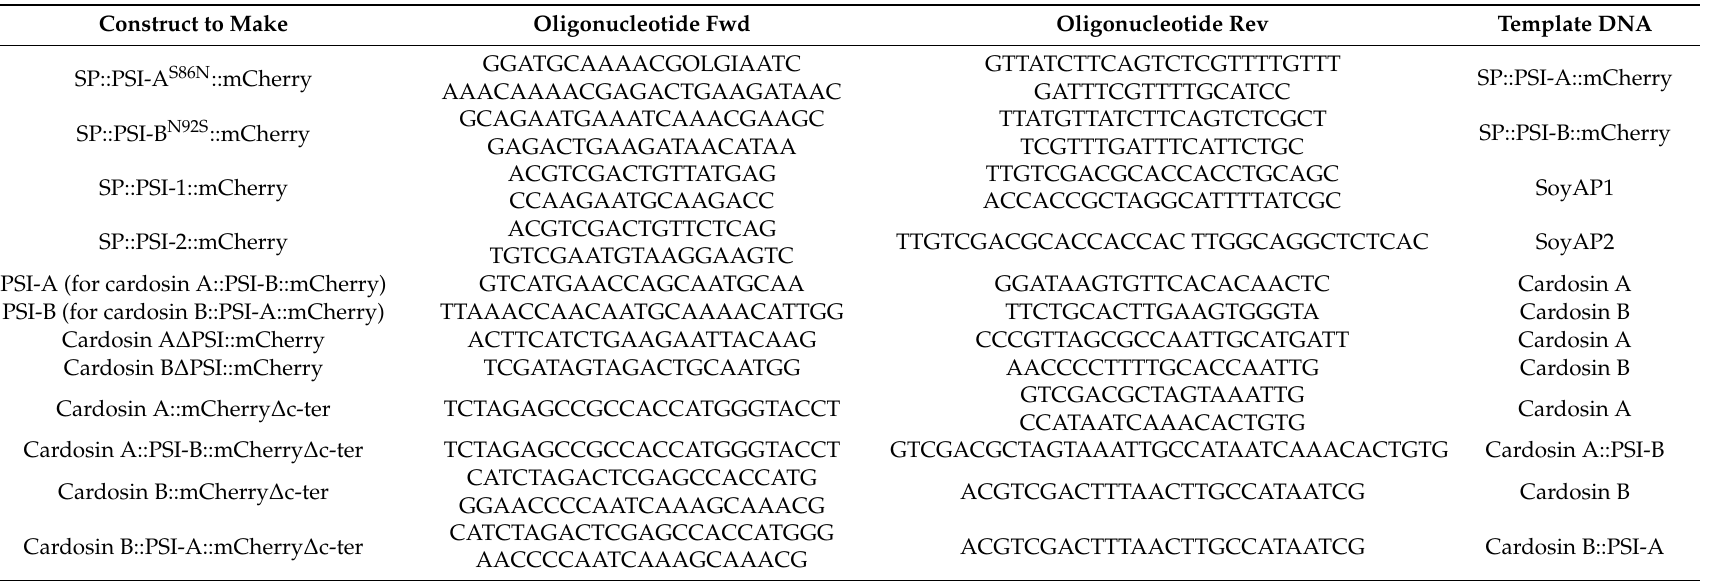
Table 1. Oligonucleotides and template DNA used to produce the constructs used along this project. Construct to